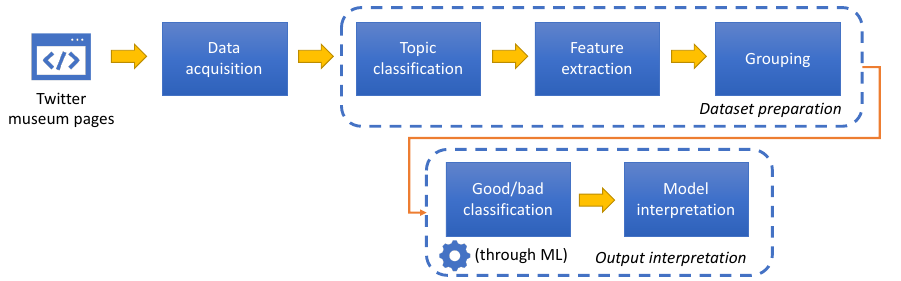
Figure 2. Dataset acquisition, preparation and analysis pipeline for the social networks analytics